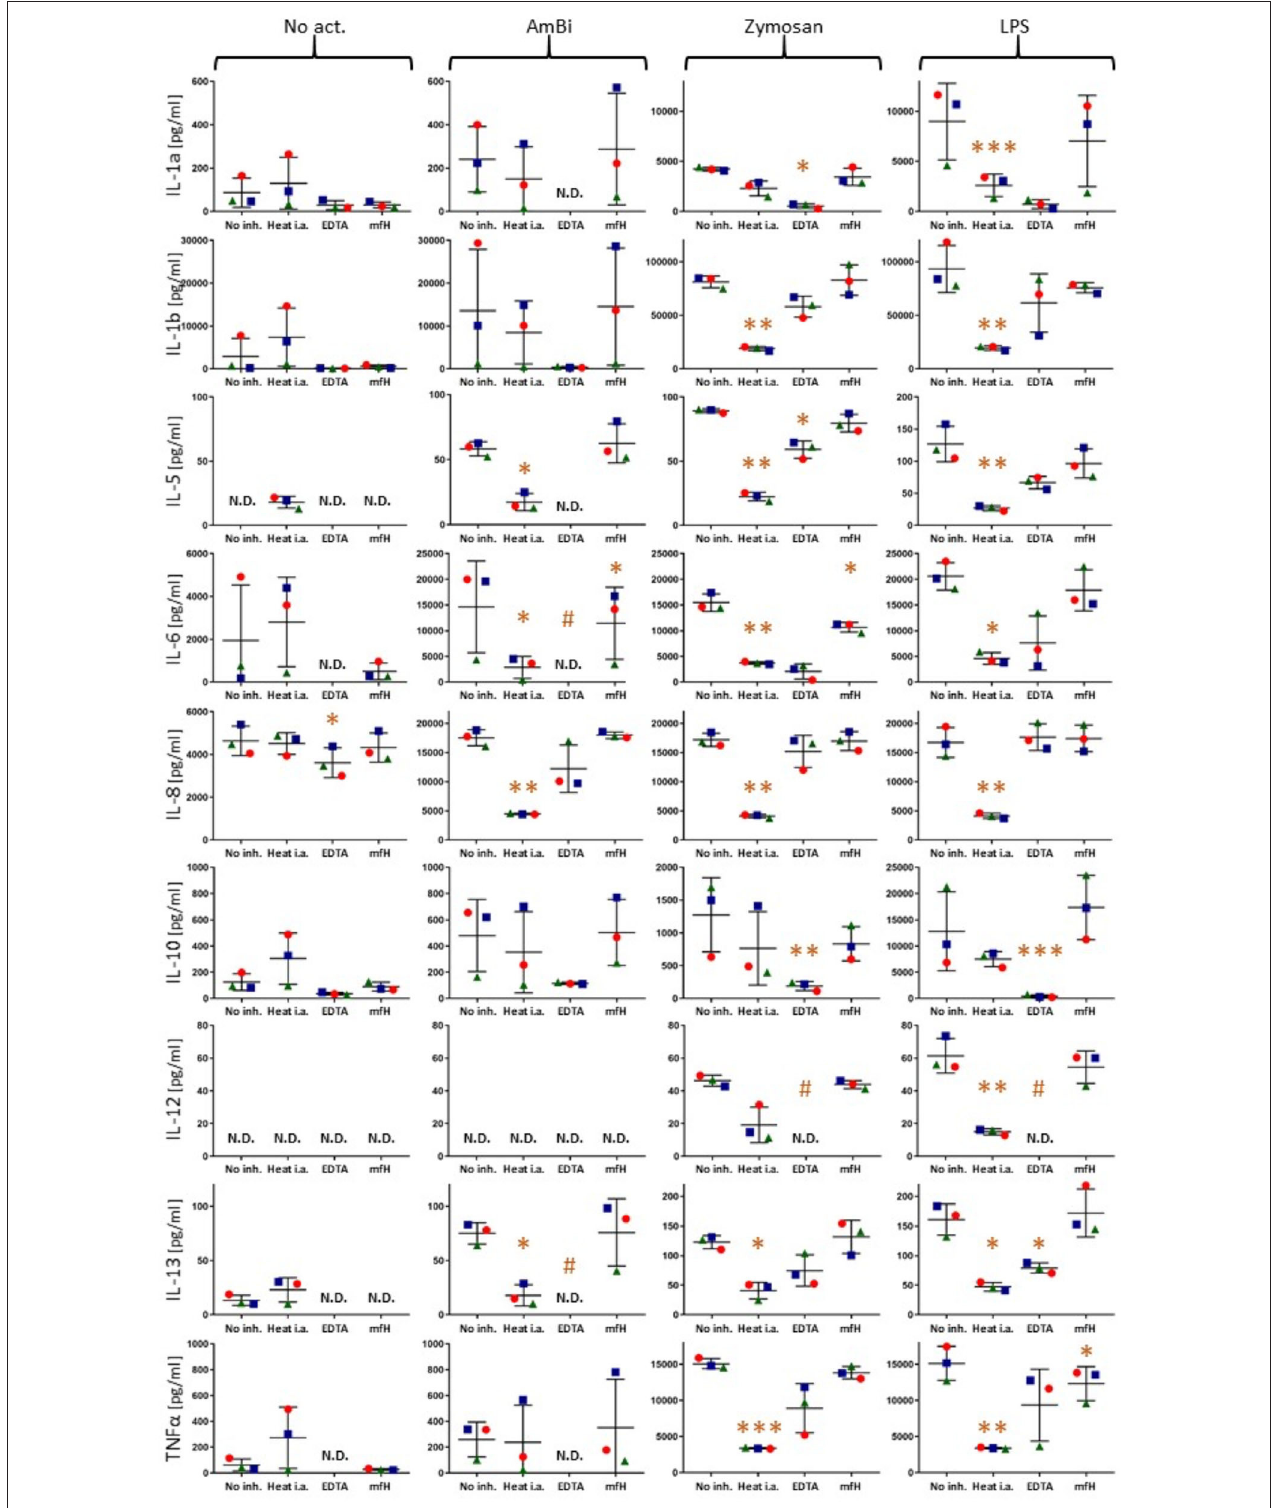
FIGURE 4 | Cytokine levels in PBMC culture supernatants after 18h activation without any activator (No act.) or with AmBisome, zymosan or LPS, as specified on the top of the figure. No complement inhibition (No inh.), or complement inhibitions of sera by heat inactivation (Heat i.a.), 20mM EDTA (EDTA), 1mM mfH are shown on the X axes. Each panel presents data for different cytokines (Y axis labels). The colored spheres, triangles and rectangles specify the three different blood donors. N.D.,